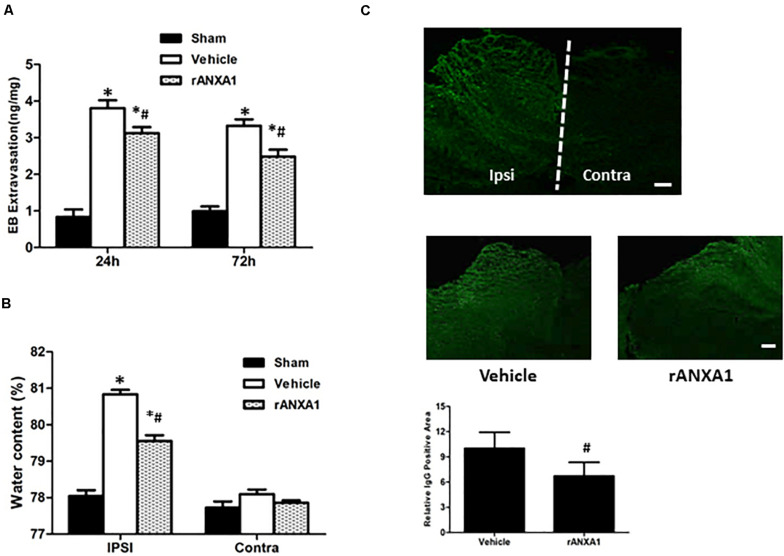
Effects of rANXA1 on BBB disruption after CCI. (A) Quantitation of extravasated Evans blue at 24 and 72 h after CCI and (B) quantitation of hemispherical water content at 24 h after CCI. After rANXA1 treatment, less extravasated dye was detected in injured hemisphere until 72 h following CCI (p < 0.05). Following CCI, the water content in the vehicle group increased remarkably in ipsilateral hemisphere. This disruption was attenuated by rANXA1 treatment with significance (p < 0.05). *p < 0.05 vs. sham, #p < 0.05 vs. vehicle, n = 8 per group. (C) Effects of rANXA1 on BBB disruption after CCI. Representative images and quantitative analysis of IgG fluorescence surrounding the lesion area at 24 h after CCI. Under fluorescence microscope, plasma-derived IgG leakage was observed in the ipsilateral cortex, striatum, and hippocampus, whereas the contralateral hemisphere was comparatively normal. rANXA1 treatment significantly reduced IgG extravasation area as compared to vehicle. Relative immunoactivity was normalized to the sham group. *p < 0.05 vs. sham, #p < 0.05 vs. vehicle, n = 5 per group. Scale bar = 100 μm.